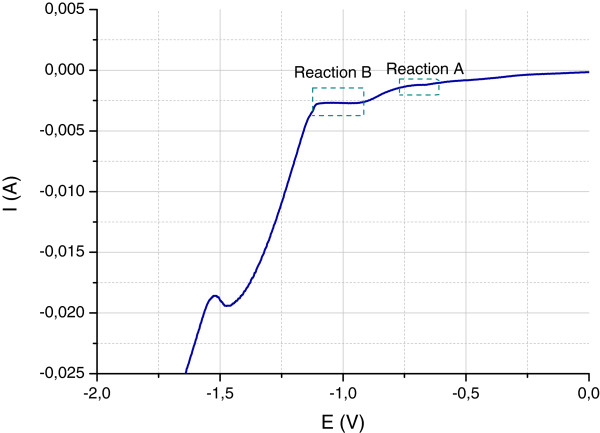
Linear voltammetry curve. ZnCl2 5 × 10−3 M and 0.1 M KCl at 70°C on ITO substrate at 0.1 V/s.